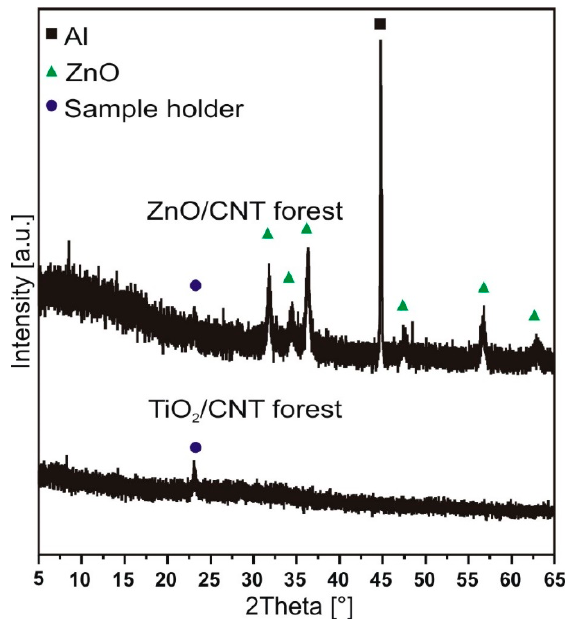
Figure 5. XRD diffractograms of the samples.